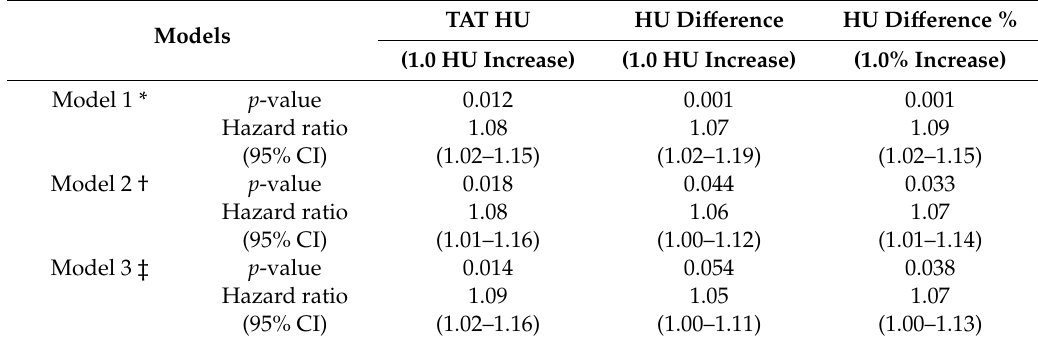
Table 4. Multivariate models for recurrence-free